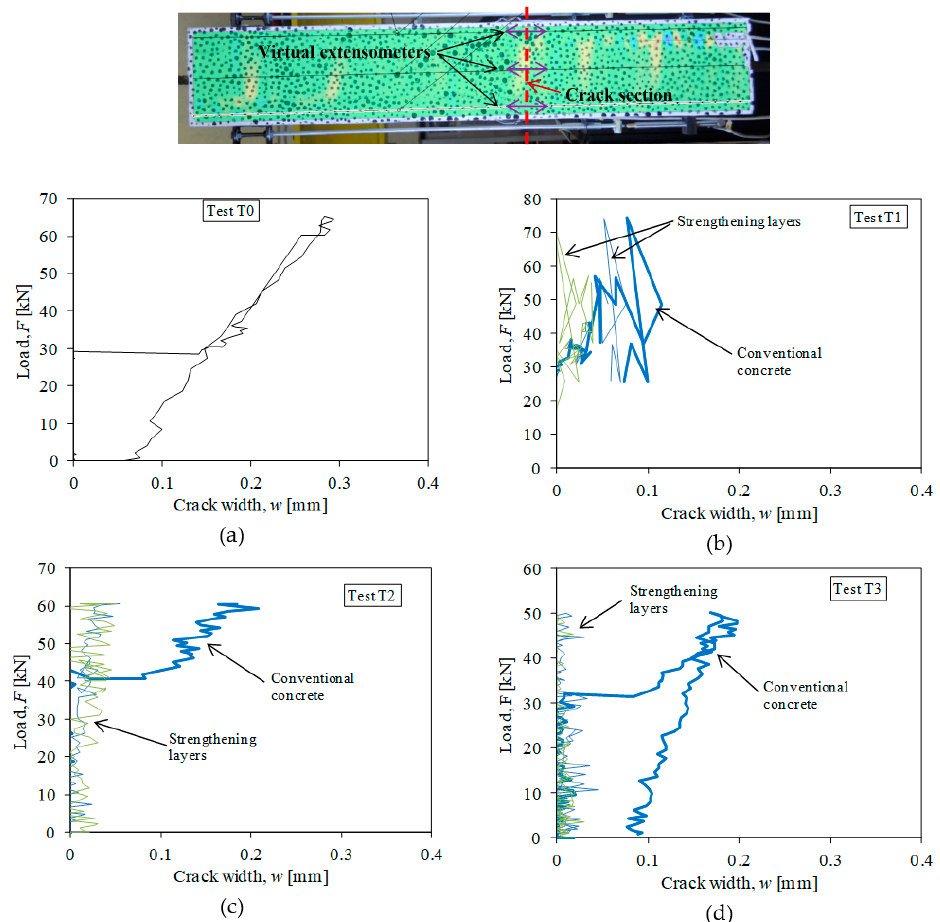
Figure 9. Location of virtual extensometers at a crack section and load-crack width diagrams of tested specimens: ( a ) Test T0; ( b ) Test T1; ( c ) Test T2; ( d ) Test T3. The small crack width at the HPFRC layers is indicative of the strain-hardening ca- pacity of the material. According to the strain hardening limit derived from material char- acterization ( ε pc = 2.5‰ in Table 1), the HPFRC would be mostly microcracked in the ser- viceability domain without formation of macrocracks. The use of strain gauges (Figure 4) allows distinguishing the local behavior at a single cross-section from the global behavior detected with the LVDTs. The sequence of crack formation and the behavioral stages of conventional concrete and HPFRC can be studied by comparing local and global measurements, as represented in Figure 10. The reference unstrengthened RC response is considered first in Figure 10a; as can be noted, the for- mation of the first crack in the specimen produces redistribution from the concrete to the steel observed with a separation of the load-strain curves from strain gauges and LVDTs. After first crack formation, the concrete prism is divided into two parts. The formation of subsequent cracks is detected with the LVDTs, but the strain gauges are only affected by the cracks formed between the gauged cross-section and the closest previously formed crack. In the case of T0, the analysis of strain gauge measurements of Figure 10 allows us to conclude that the strain gauges have been attached at a section between the first and third cracks.